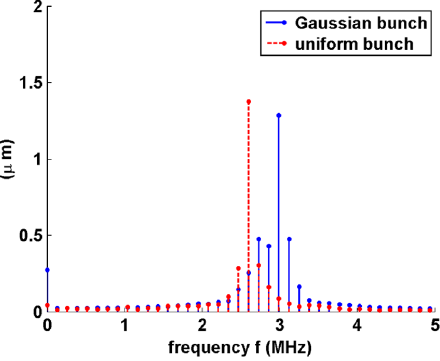
FIG. 3. Fourier analysis of the oscillation of a H þ 2 ion cloud around the beam potential of a 50 MeV bunch.